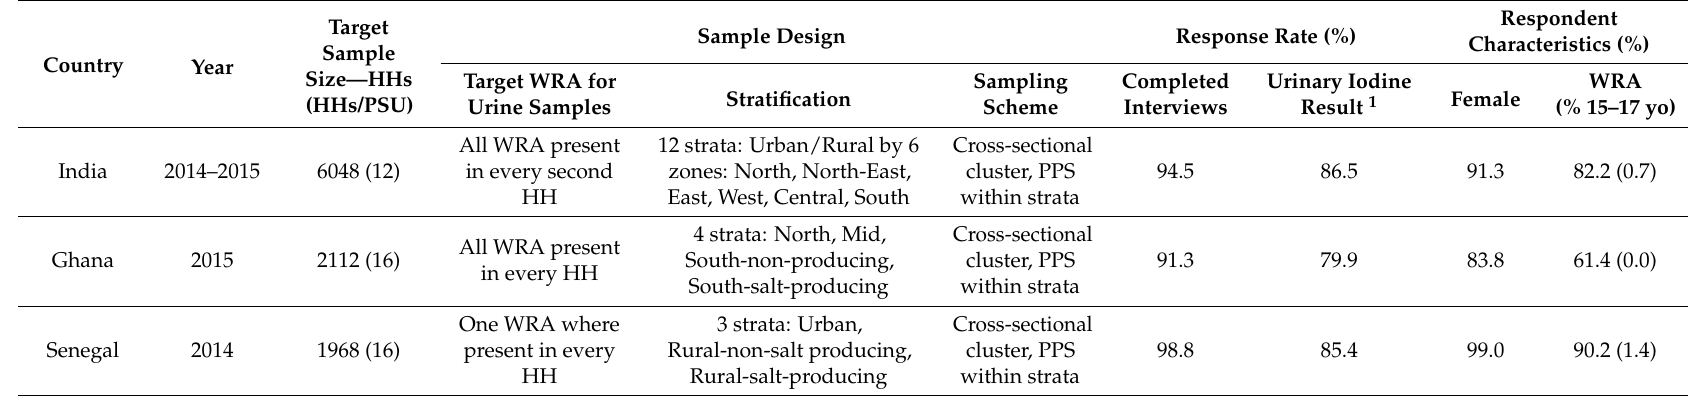
Table 1. Overview of the survey design, response rate, and respondent characteristics for each